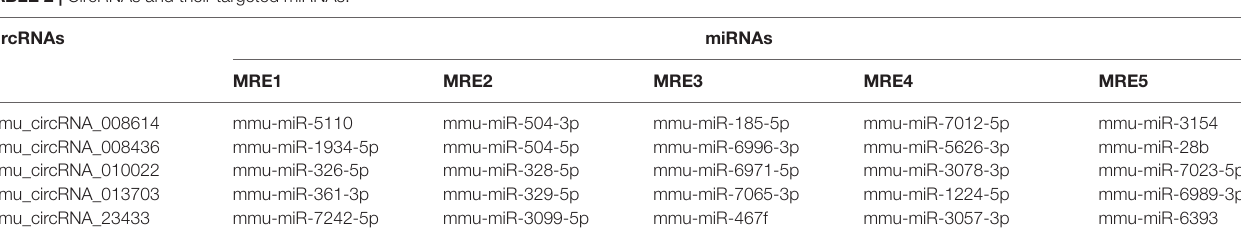
TABLE 2 | CircRNAs and their targeted miRNAs.